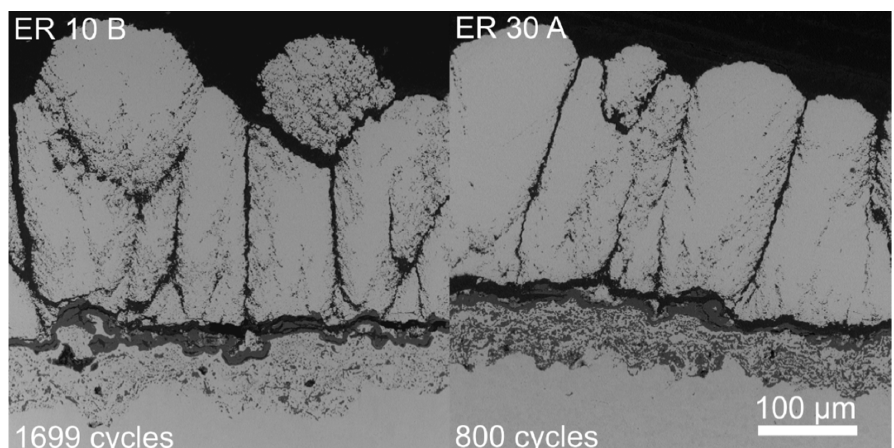
Figure 3. SEM cross section of thermally cycled TBCs using columnar yttria-stabilized zirconia SPS top coat, Co-based alumina oxide-dispersion-strengthened bond coats (10% and 30% alumina) and conventional Co-based bond coat underneath (on ERBO 1 substrate—not visible).